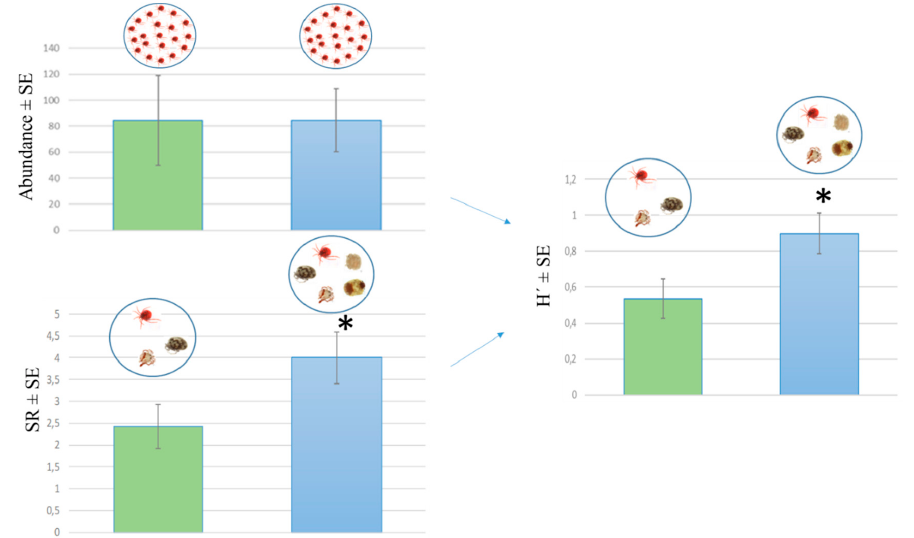
Figure 3. Illustration of the differences in water mite diversity (Shannon index, H’) between limnocrenes (with green bars) and rheocrenes (with blue bars) as a result of water mite abundance and species richness (SR). Columns represent average values, whereas error bars represent the calculated standard errors (SE). The asterisk * indicates statistically significant ( p < 0.05) differences between spring morphotypes ( t -test).